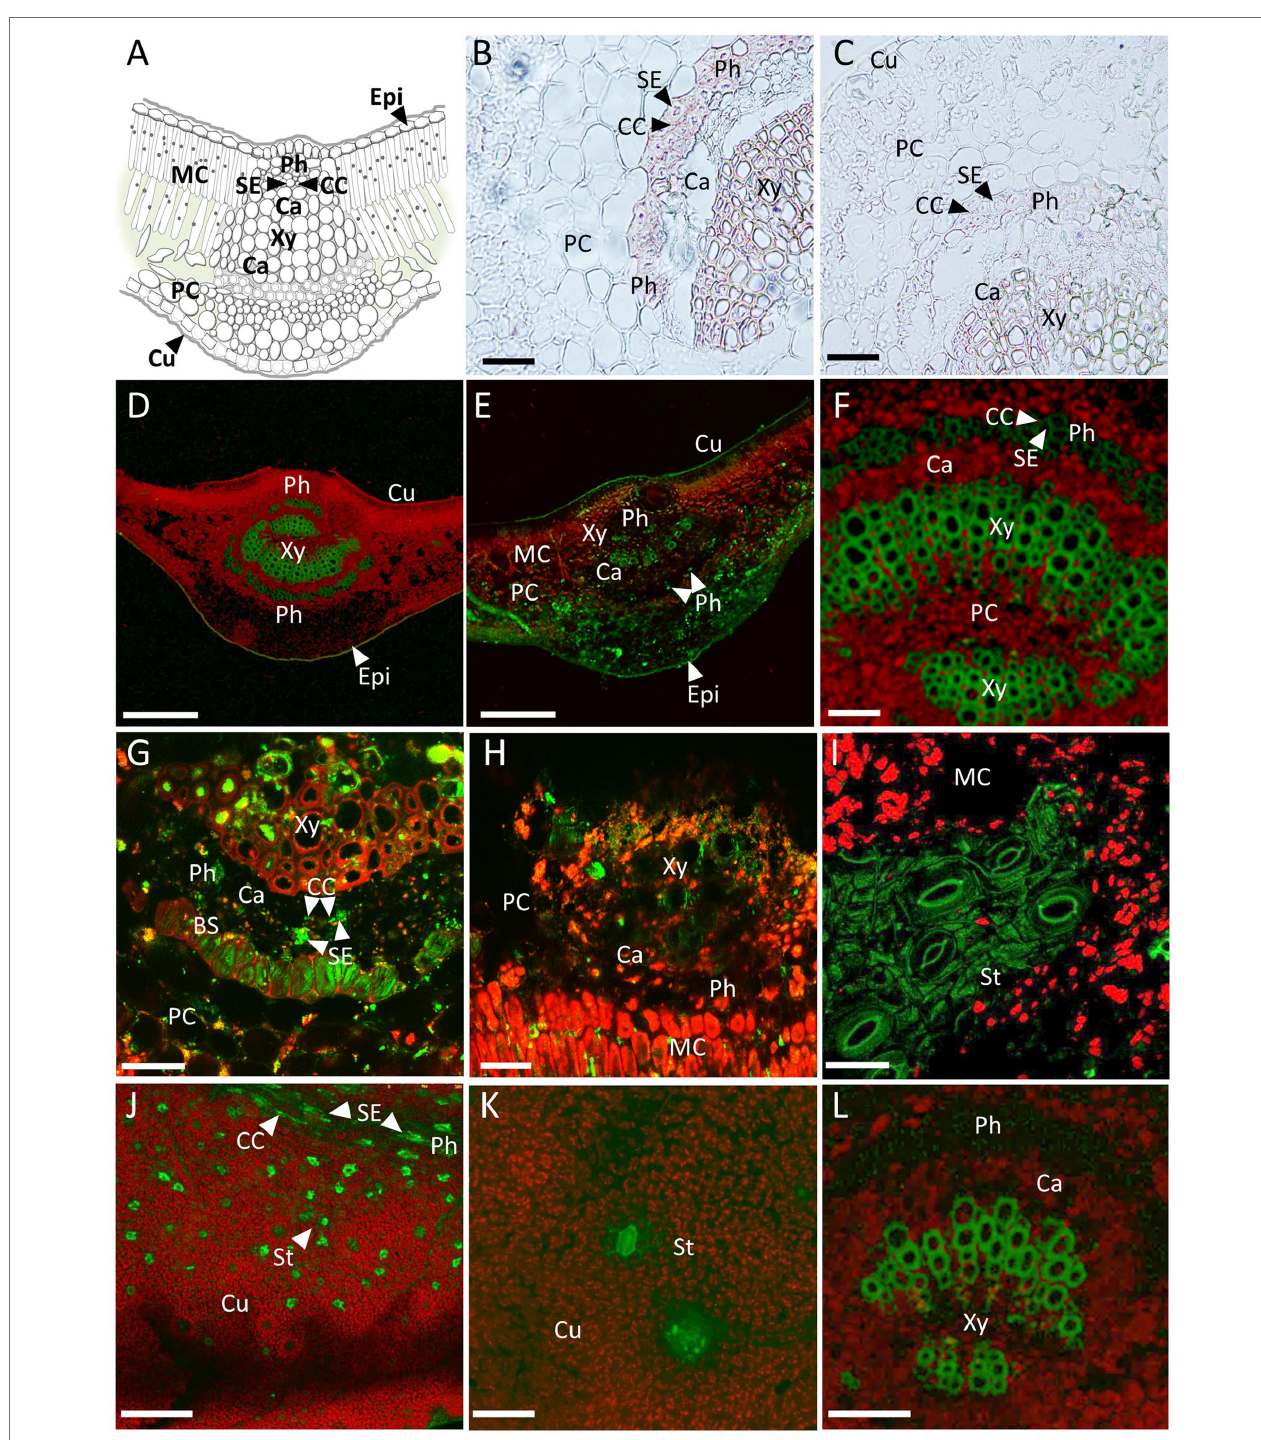
FIGURE 4 | In situ localization of mobile CsPP16 translationally fused to antimicrobial proteins and GFP. (A) Schematic representation of transverse section of a central vein of Citrus leaf; (B) immunolocalization of β -defensin fused to CsPP16 in a leaf transverse section; (C) negative control of immunolocalization; (D–F) confocal images of transverse sections of leaves vein expressing β -defensin fused to CsPP16 and GFP; (G,H) transverse sections of main vein expressing CsPP16-magainin-GFP; (I) cuticle expressing same construct as in (G,H) images showing open stomata; (J) isolated mesophyll cells containing mobile proteins magainin fused to GFP, upper region showing a longitudinal fluorescent minor vein; (K) closed stoma on leaf surface containing the fused, mobile magainin; and (L) negative control displaying autofluorescence of xylem tissue. BS, Bundle Sheath; Ca, Cambium; CC, Companion Cell; Cu, Cuticle; Epi, Epidermis; MC, Mesophyll Cell; MV, Minor Vein; Ph, Phloem; PC, Phloem Parenchyma; SE, Sieve Element; St, Stoma; and Xy, Xylem. Scale bar for panels (B,C,F,I,L) = 50 μ m; (D,E,J) = 250 μ m; (G,H) = 25 μ m; and (K) = 100 μ